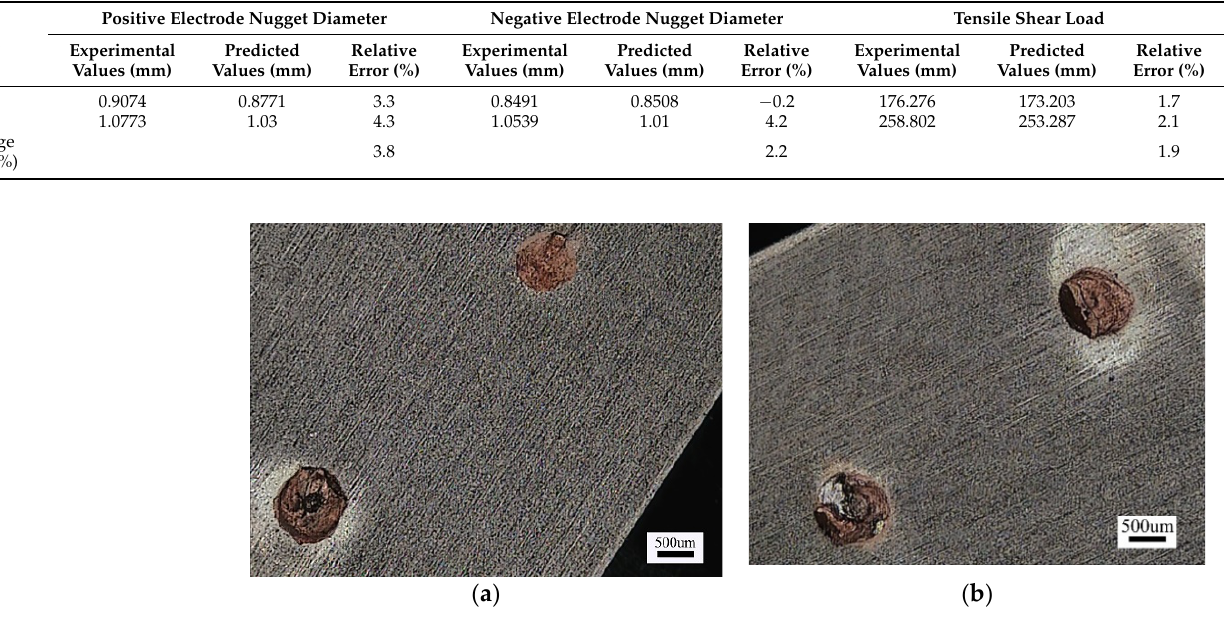
Table 8. Method I verification of relative error.